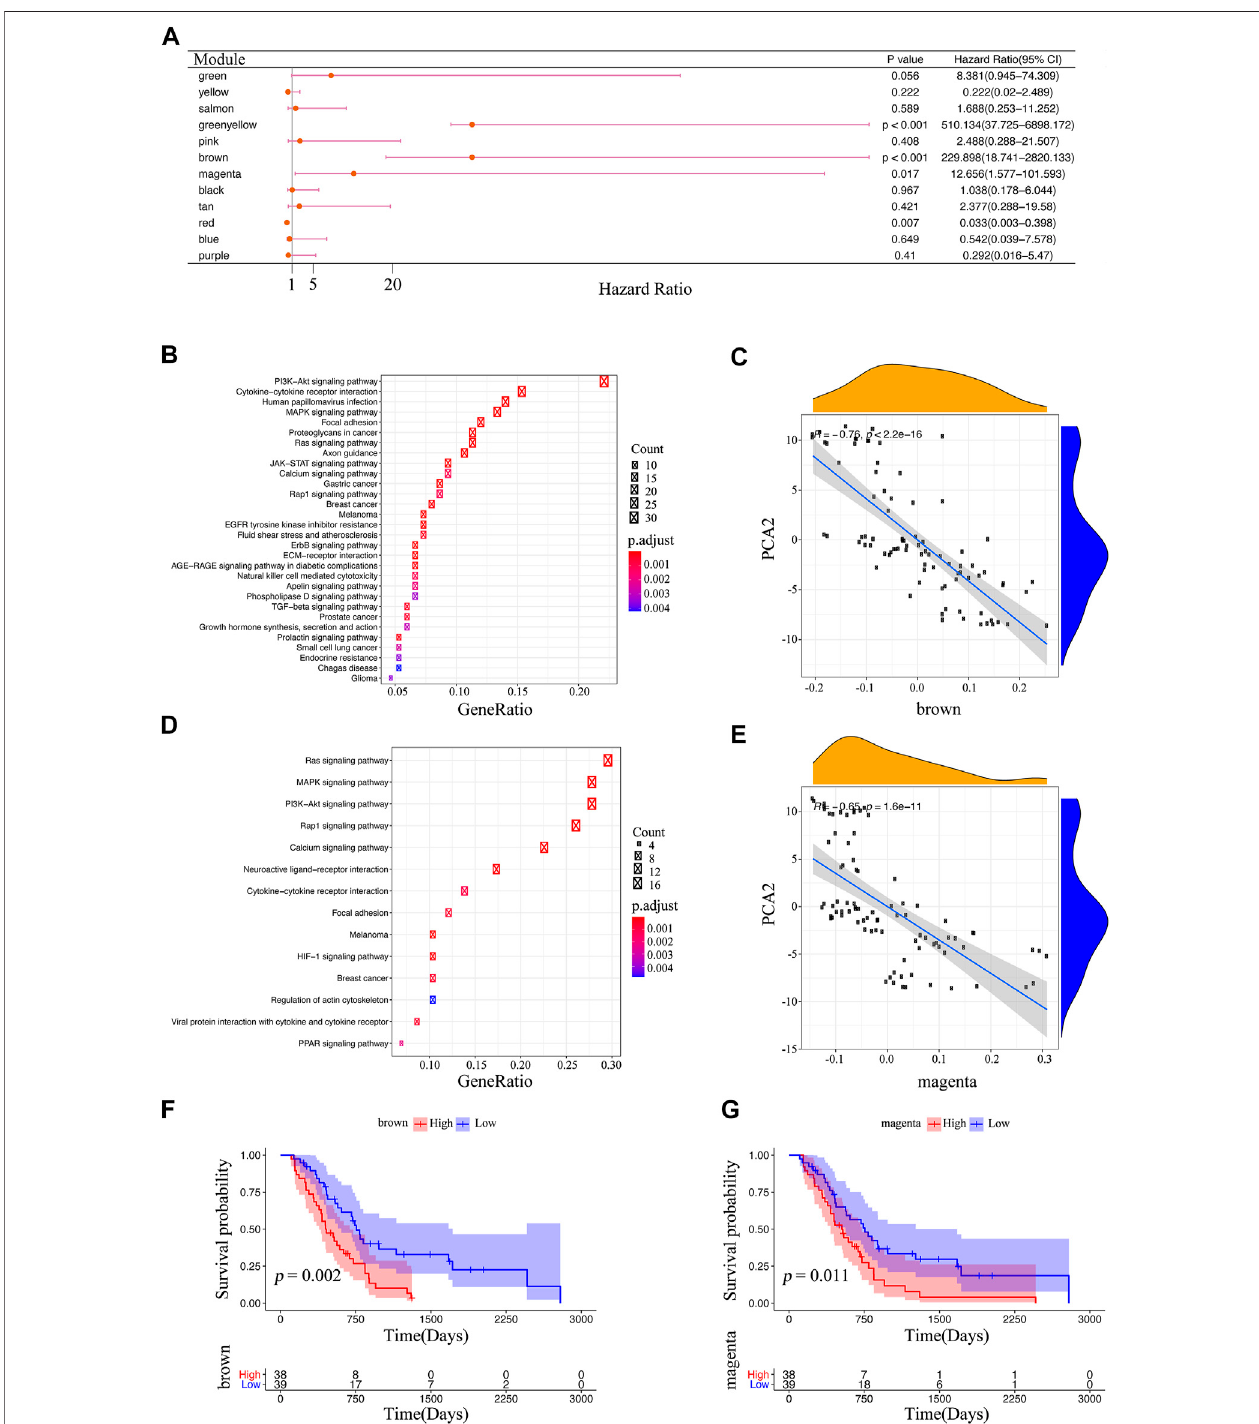
FIGURE 10 | Identi fi cation of immune core genes (A) Survival analysis of eleven modules. The enrichment results of KEGG in the brown module (B) and the magenta module (D) (C,E) The association between the feature vector of the modules and PCA2 in the immune landscape; the brown module (C) , and the magenta module (E) (F,G) Kaplan-Meier curves of the brown module (F) , and magenta module (G) .